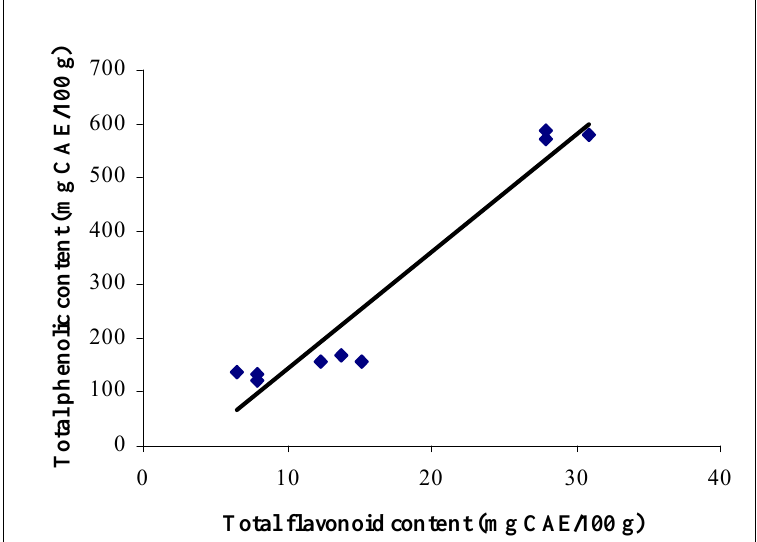
Figure 1. The correlation between total phenolic and flavonoid